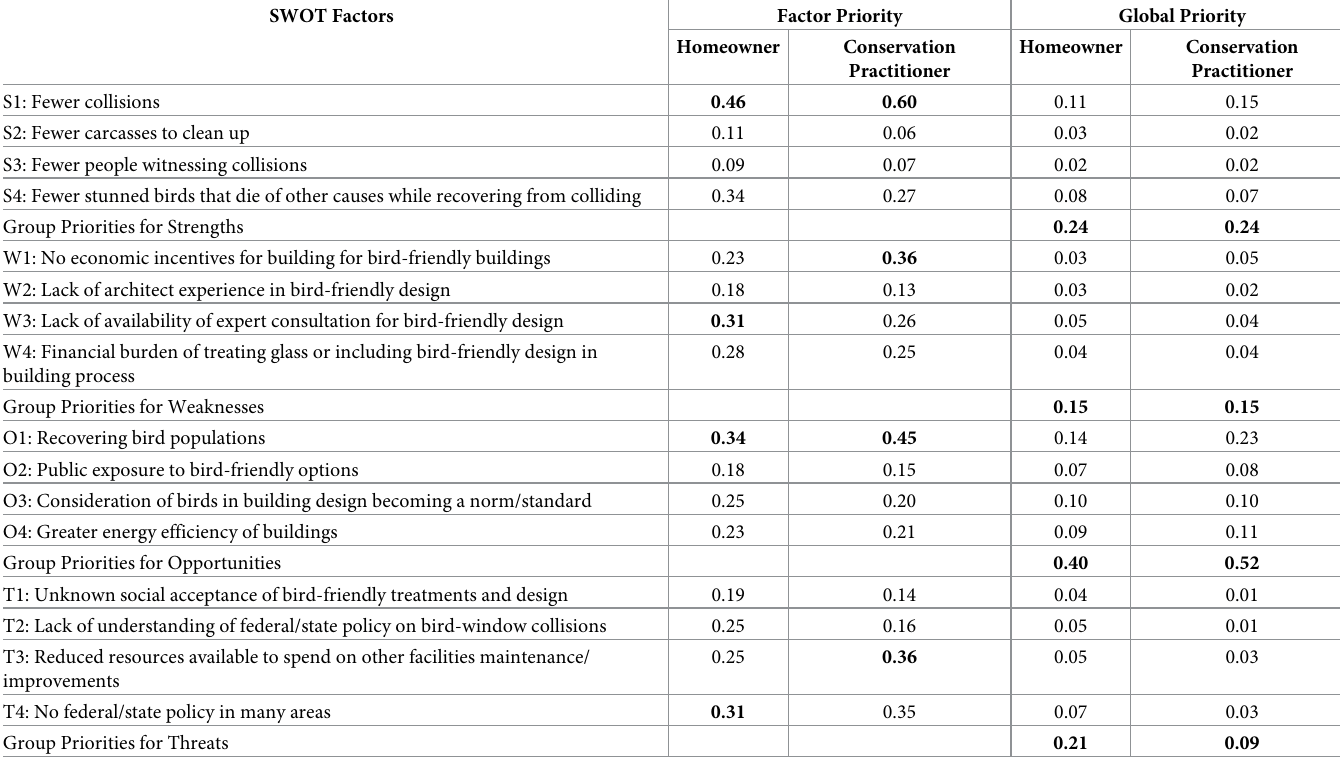
Table 2. Factor, global, and group priorities for all SWOT factors for each stakeholder group.